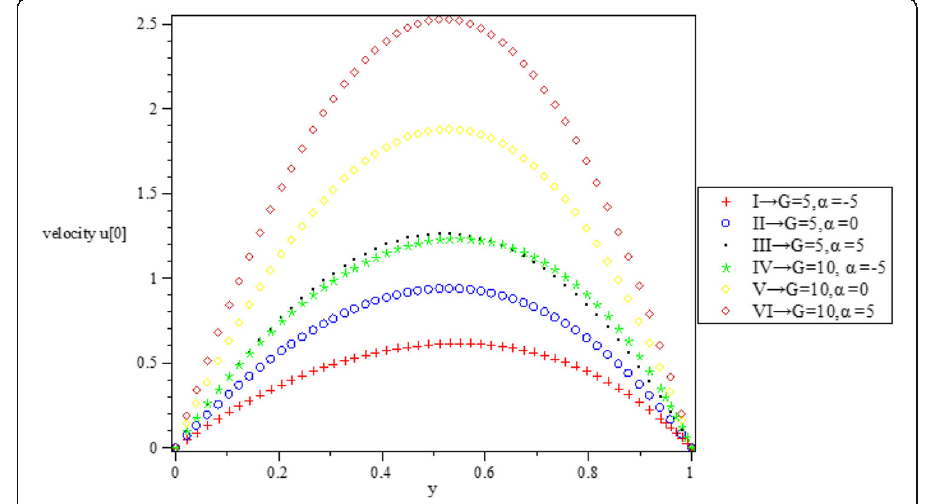
Fig. 3 Zeroth-order velocity (u[0] profile, r = 2 and β =